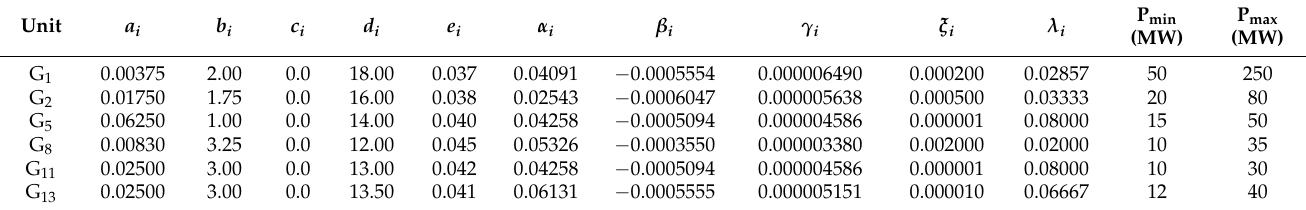
Figure A1. Single-line diagram of the IEEE 30-bus test system. Table A1. System data of units with single-fuel coefficients considering valve-point effect and emission coefficients.